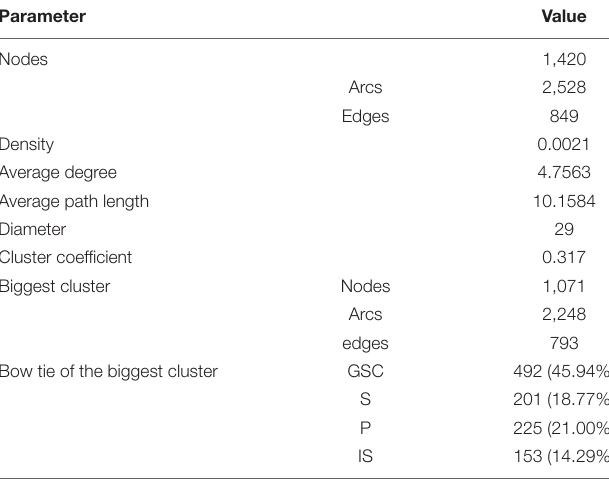
TABLE 3 | Basic topological features of Y-organ GSMN.